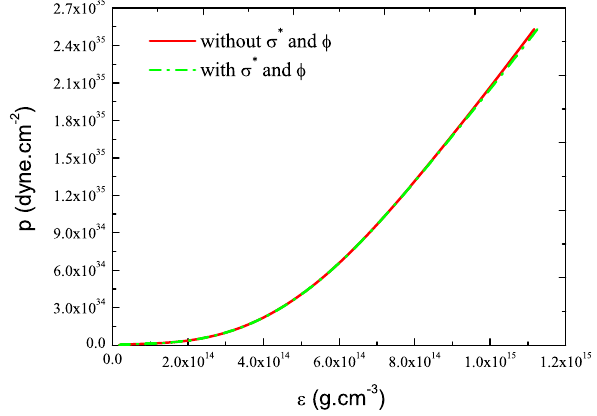
Fig. 6 The relative density of baryons in PNS as a function of the baryon density ρ . The thick solid red curves represent the case where the hyperon interaction is not considered, while the green virtual curves represent the case where the hyperon interaction is